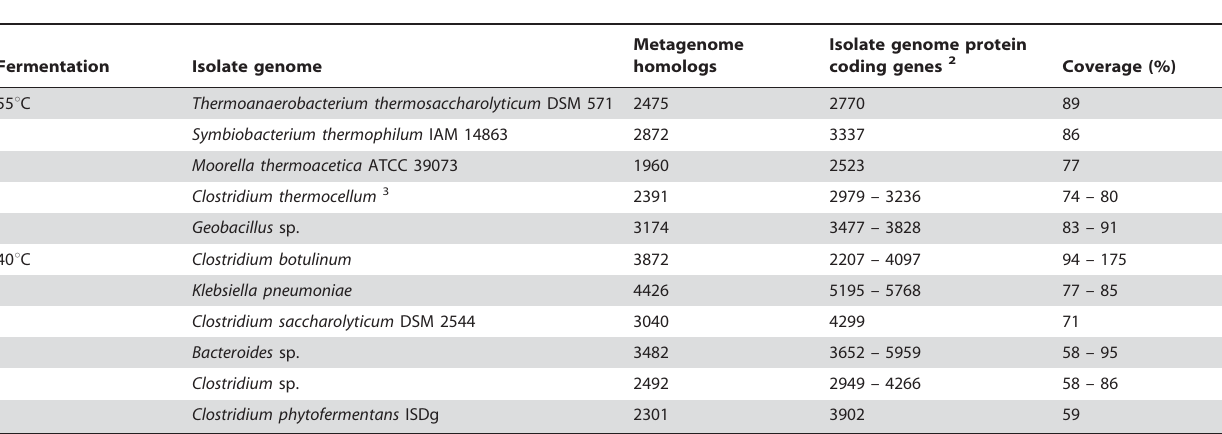
Table 4. Metagenome coverage of isolate genomes.